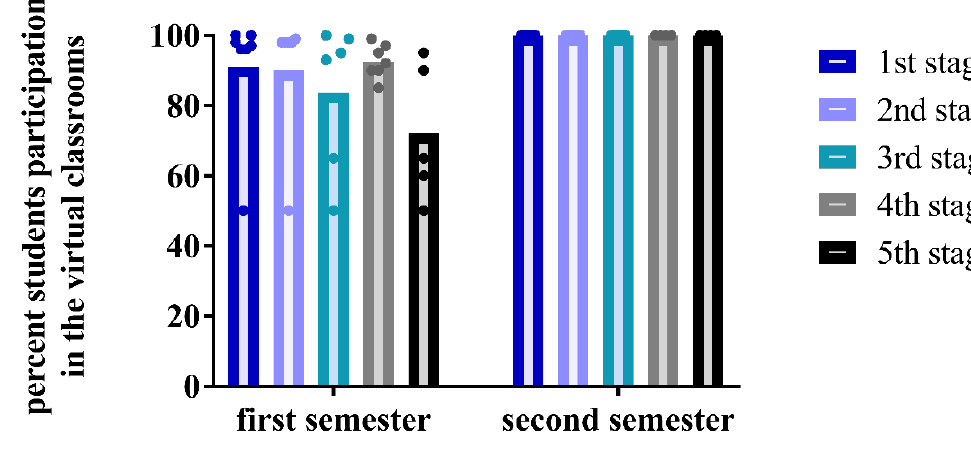
Figure 2. Students participation in virtual classrooms by grade.